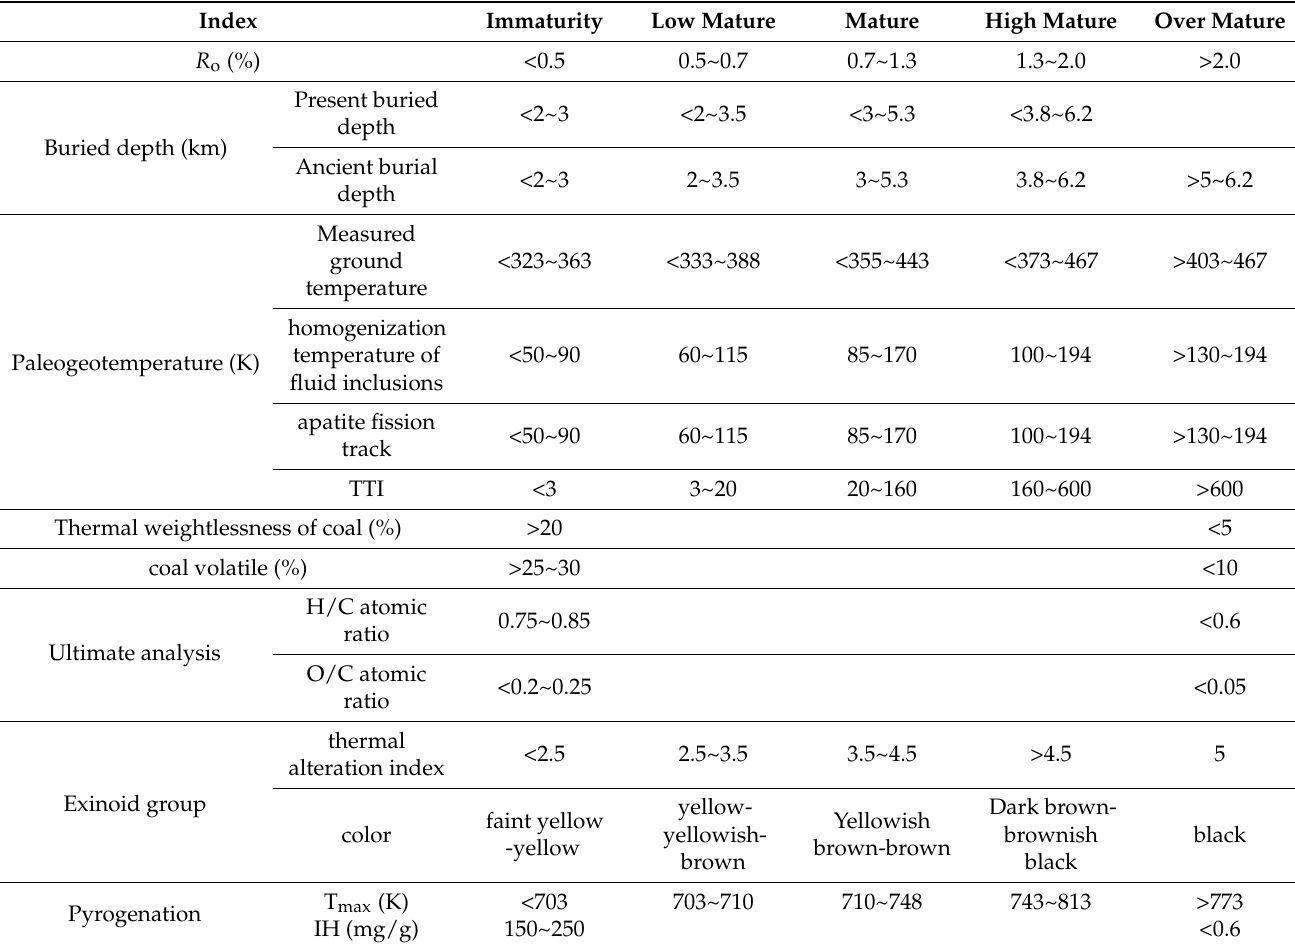
Table 3. Main indicators for classification of mature stages of coal measures source rocks